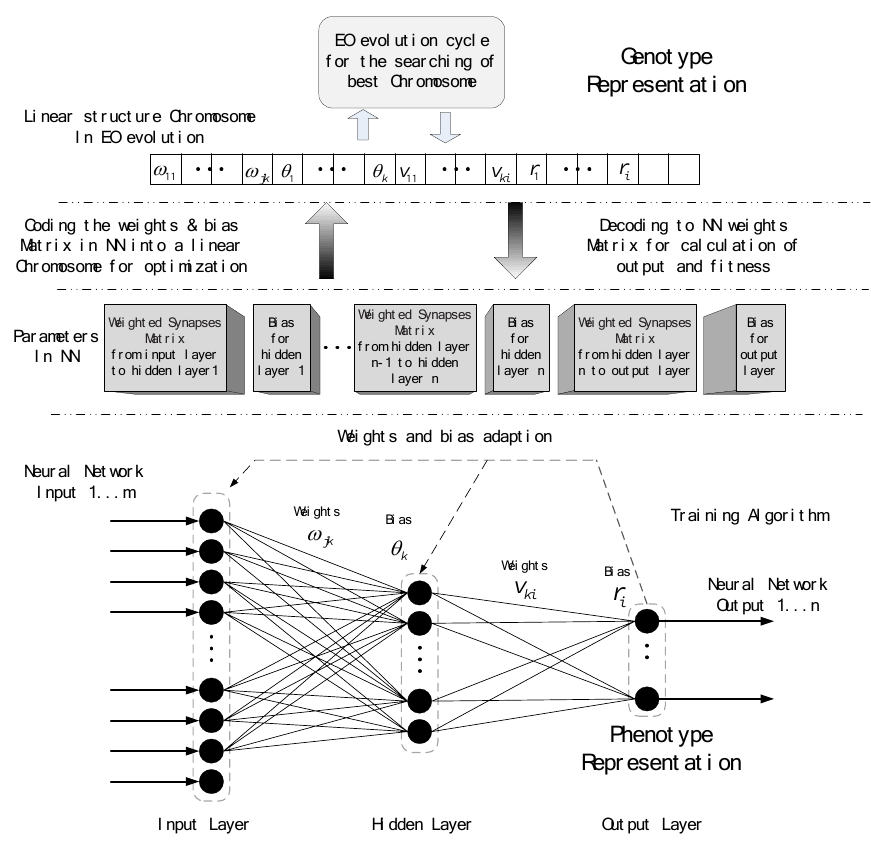
Fig. 1. Mapping neural network weights/biases from Phenotype space into a linear chromosome of Genotype